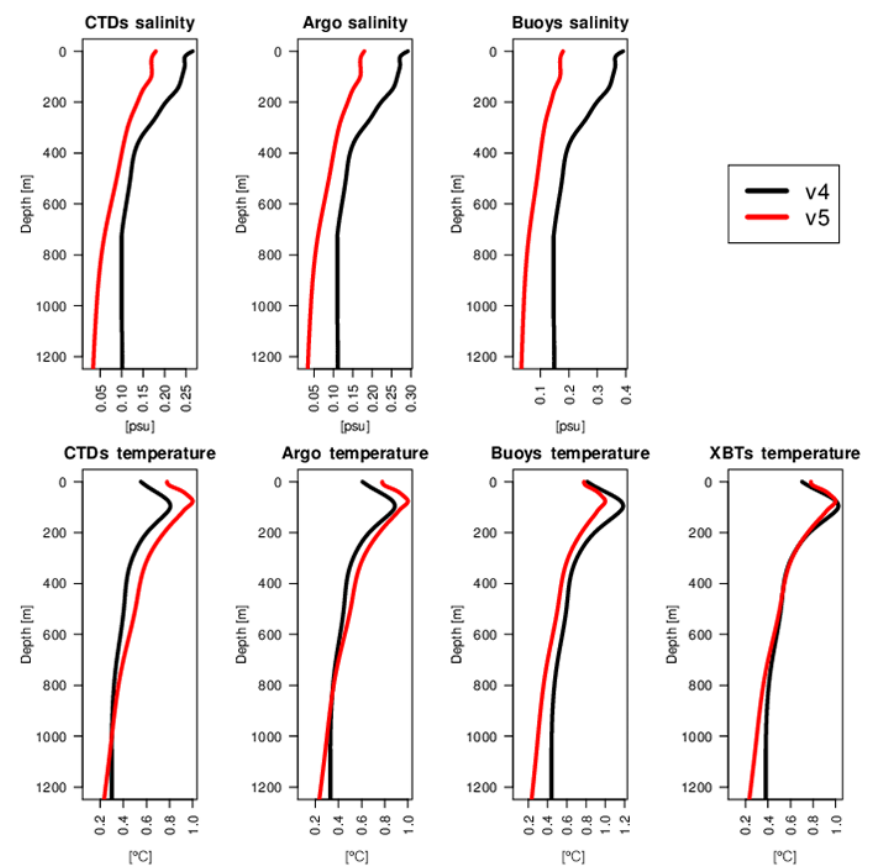
Figure 1. Observation-error profiles for use in the in situ data assimilation in C-GLORSv4 (black lines) and v5 (red lines), as a function of parameter and observation